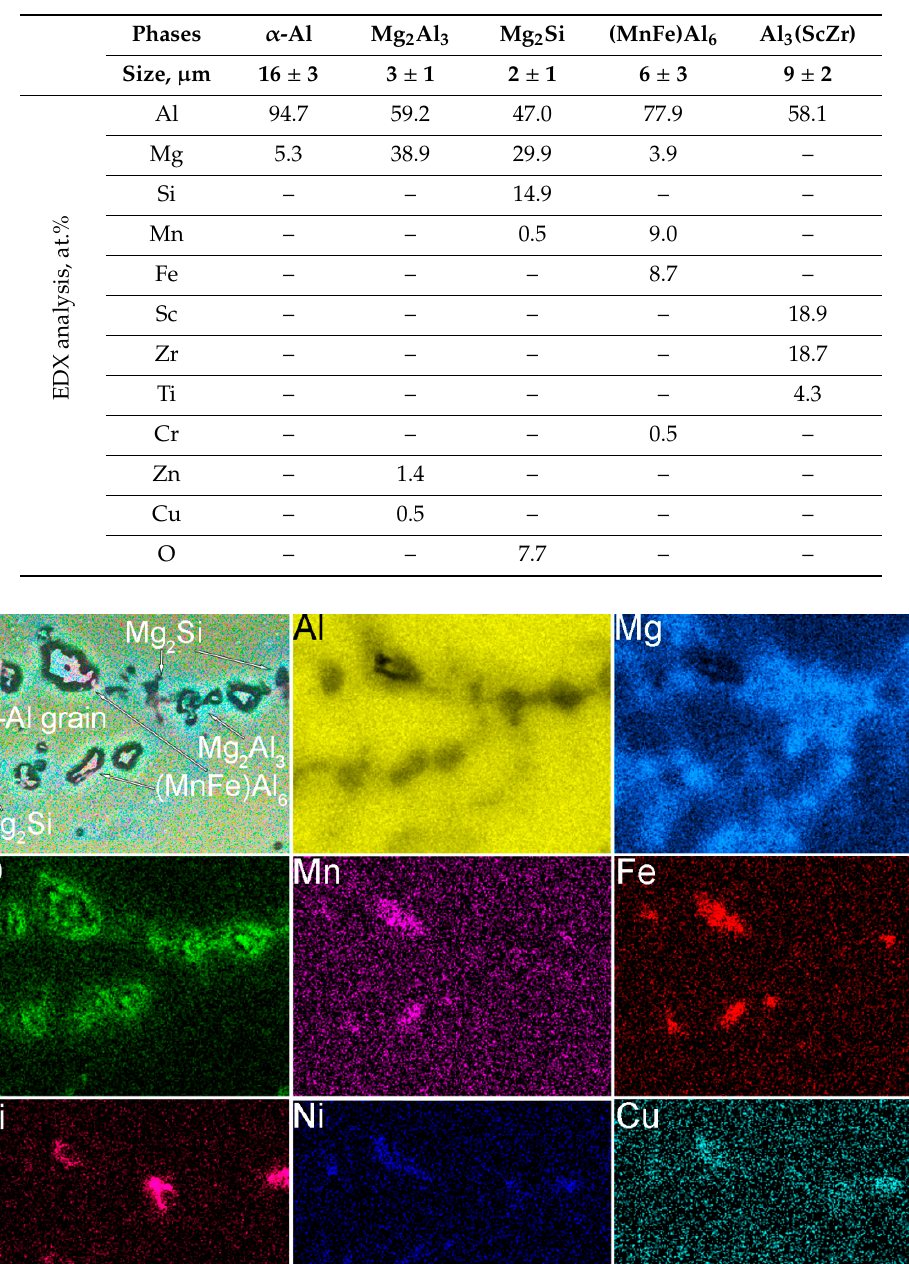
Table 3. Size and composition of α -Al matrix grain and secondary phases in HAZ of 1579 Al alloy weld.